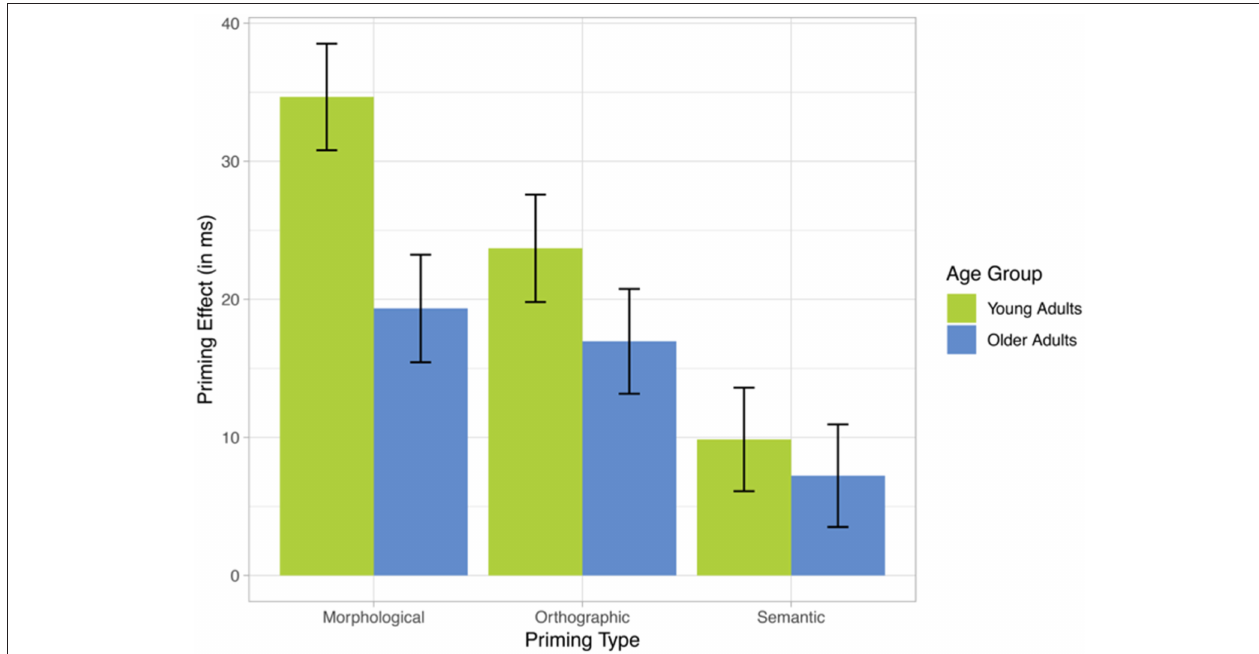
FIGURE 1 | mean primary effects (RTs in control minus primary condition), and standard errors, in morphological, orthographic, and semantic conditions, in younger and older French-speaking adults.